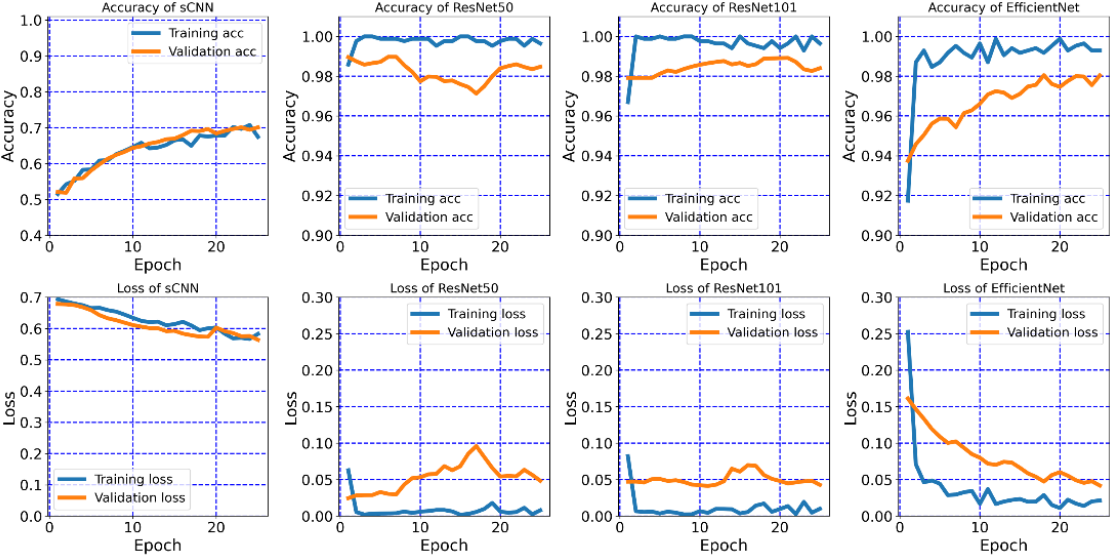
Figure 5. Accuracy and loss of each model on the training and validation dataset.